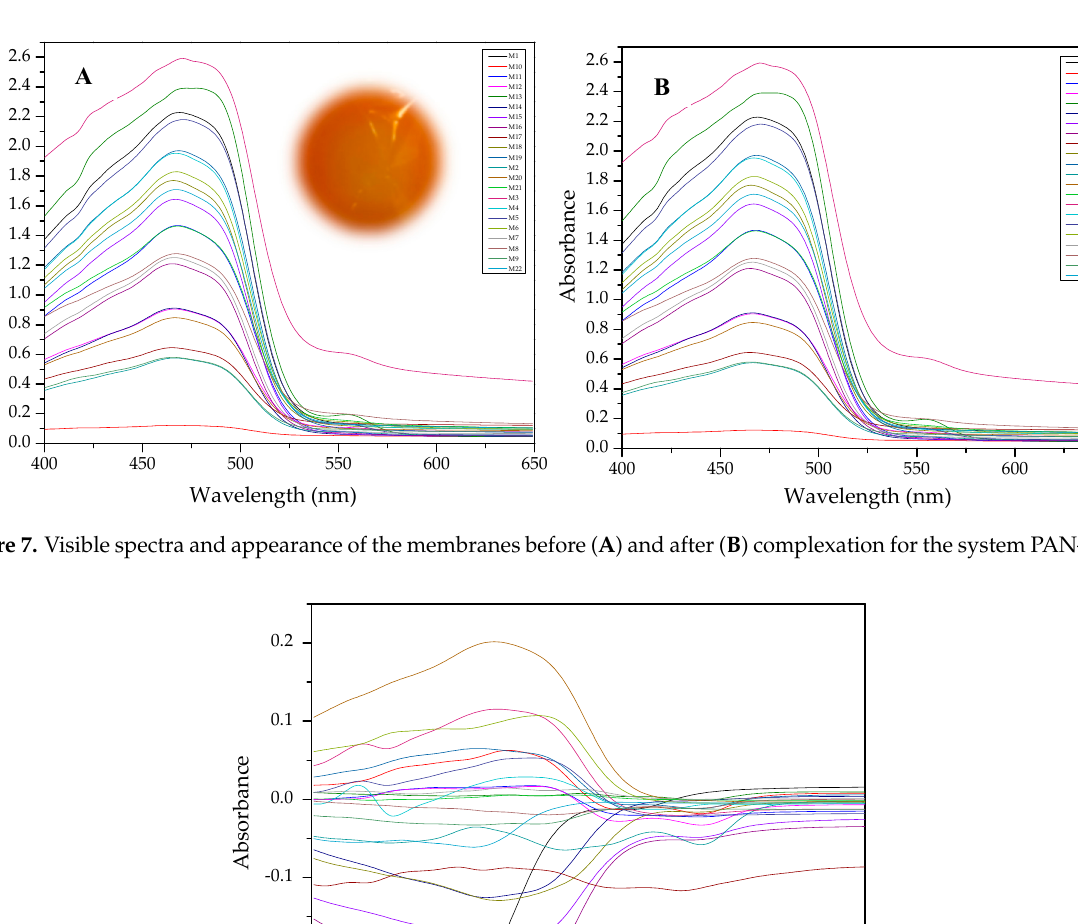
Membranes 2021 , 11 , x FOR PEER REVIEW